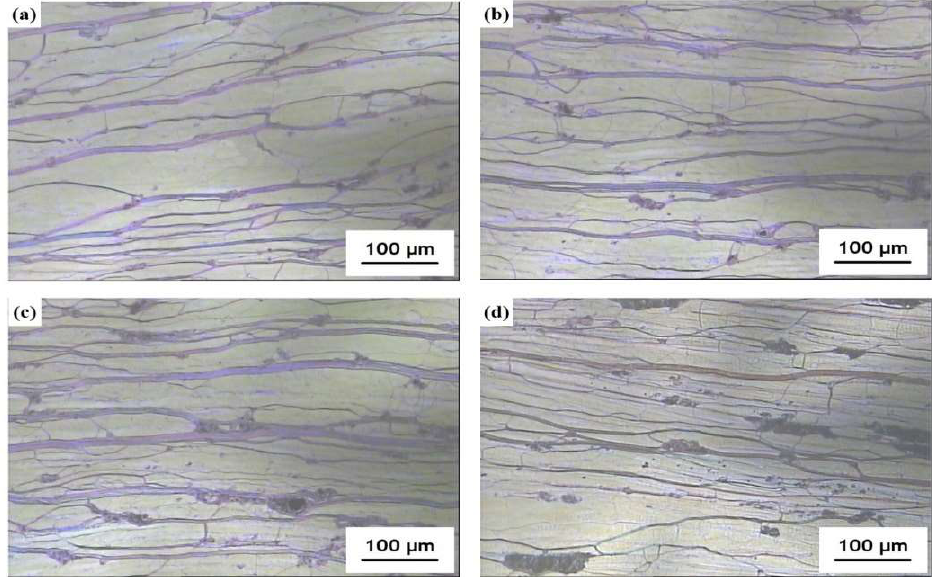
Figure 2. POM images of LC samples doped with various modified CNT/PVP concentrations: ( a ) 0.2 wt.%, ( b ) 0.5 wt.%, ( c ) 0.8 wt.%, and ( d ) 1.0 wt.%.